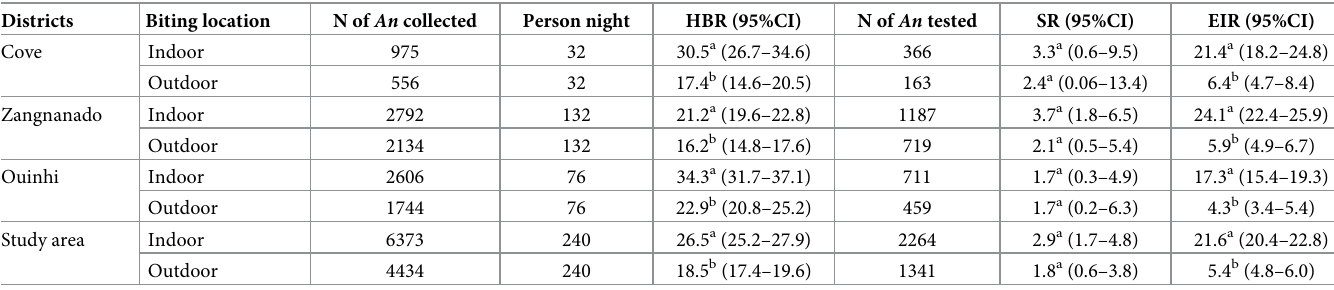
Table 3. HBR, SR and EIR in An . gambiae s.l. in Cove, Ouinhi and